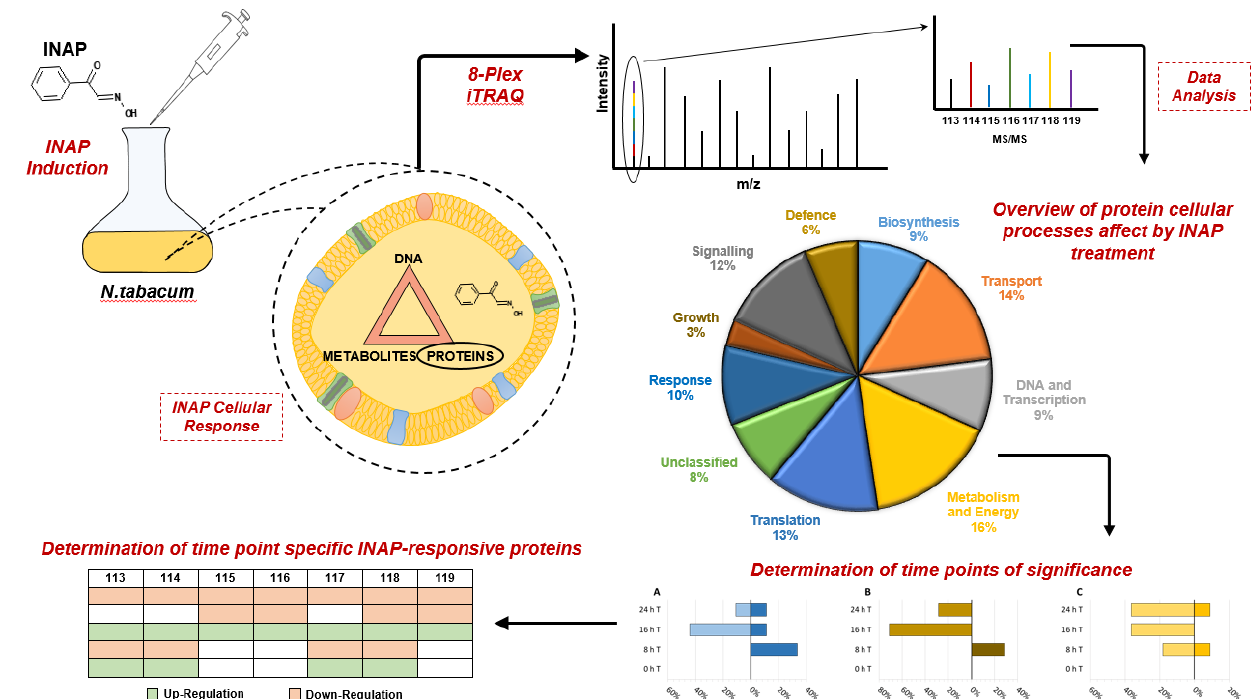
Figure 4. A graphical abstract indicating the proteome processes affected by N. tabacum cellular treatment with INAP.